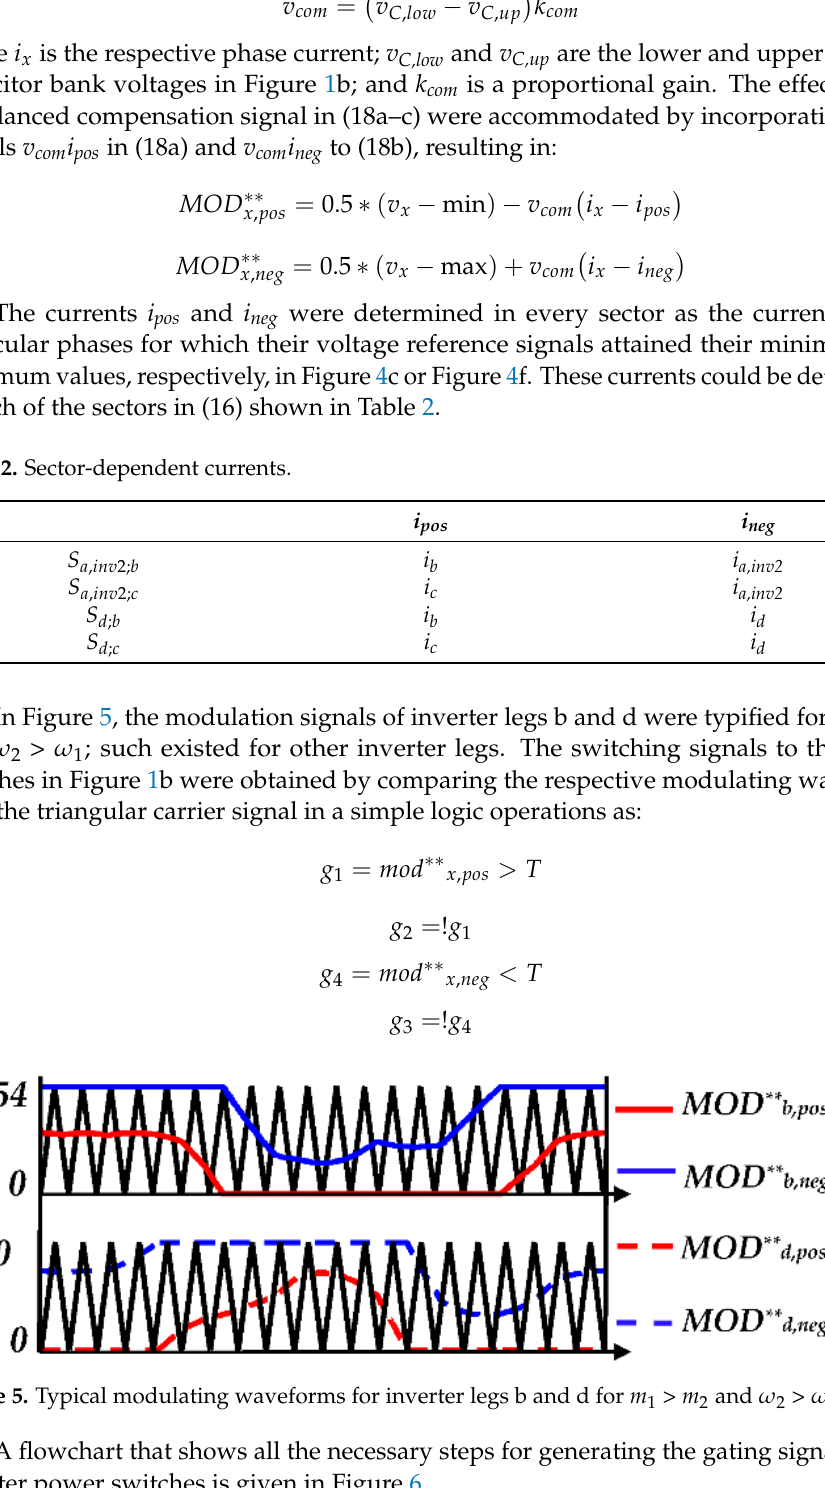
Table 2. Sector-dependent currents.